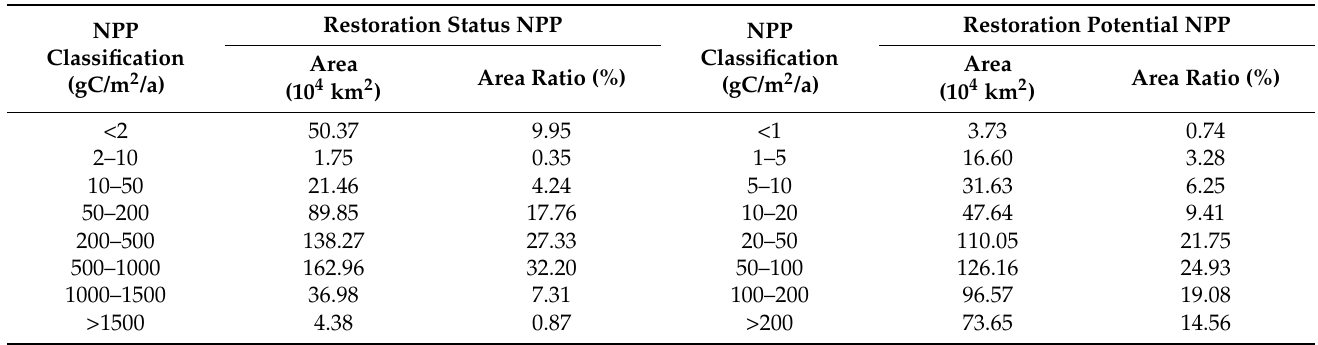
Table 8. Classification statistics of the restoration status and restoration potential of NPP in China’s forest, grassland and desert ecosystems.